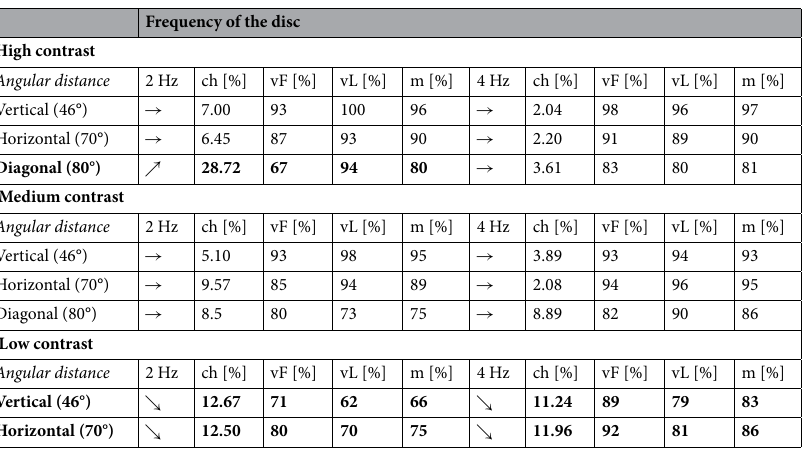
Table 3. The collective representation of habituation and sensitization for high, medium, and low contrasts, considering the flashing disc’s frequency (in Hz) and different angular distances (in degrees). A red arrow represents habituation; a blue arrow represents sensitization, and a gray arrow represents neutral to low habituation. Changes between the first (vF: first stimuli for the setup, given, given in %) and the last (vL: last stimuli for the setup, given in %) stimulus display are shown in the ch (change) column given in %, while the average value of the disc visibility in the m column (mean) is given in %. The setups with a habituation/ sensitization effect with a change above 10% are marked with bold